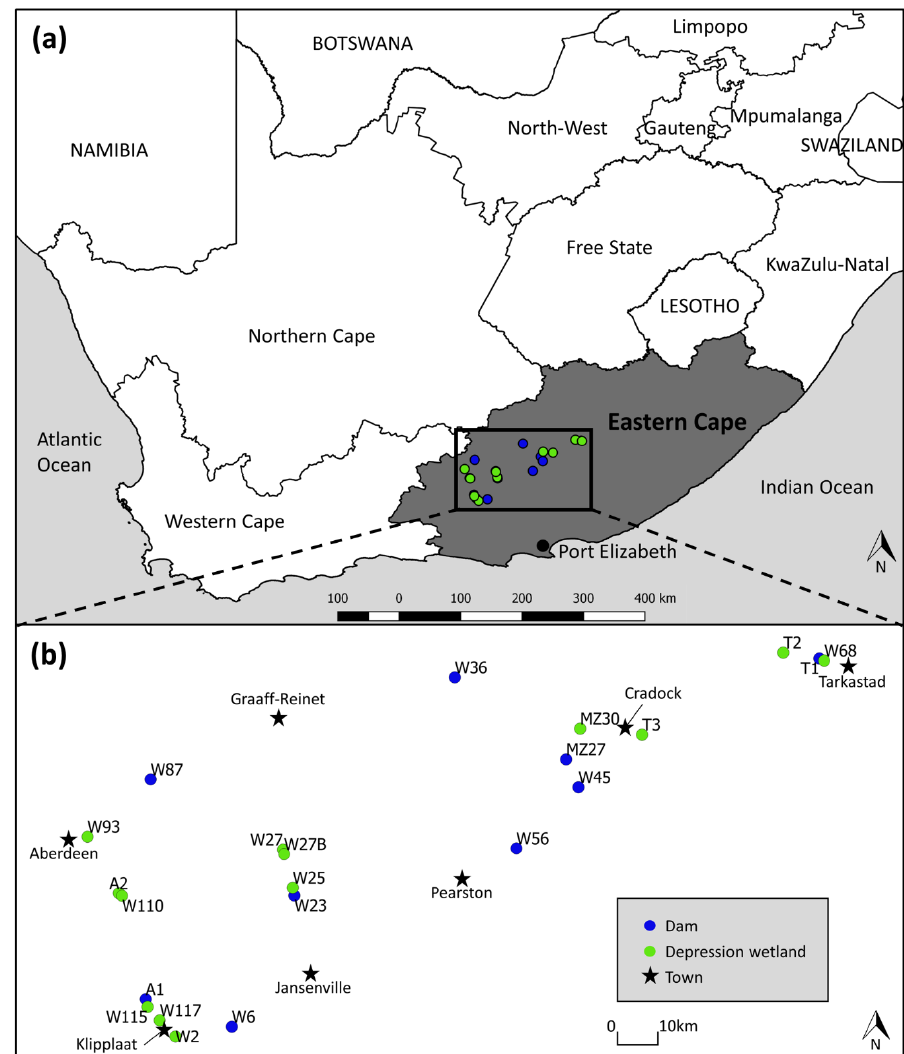
Figure 1. Location of the sites sampled for large branchiopods in the Eastern Cape Karoo region of South Africa ( a ), including a zoomed-in perspective of the 22 sites within the focal study area ( b ).